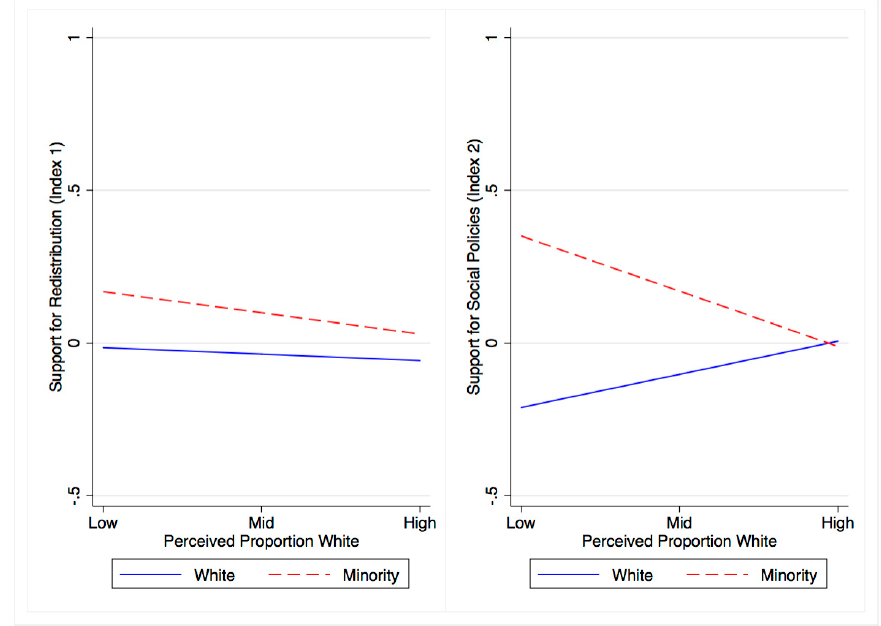
Figure 6. Bivariate fitted linear regression lines of support for redistribution and social policies indices (standardized) and perceived neighborhood proportion of whites by respondent race. Societies 2018 , 8 , x FOR PEER REVIEW